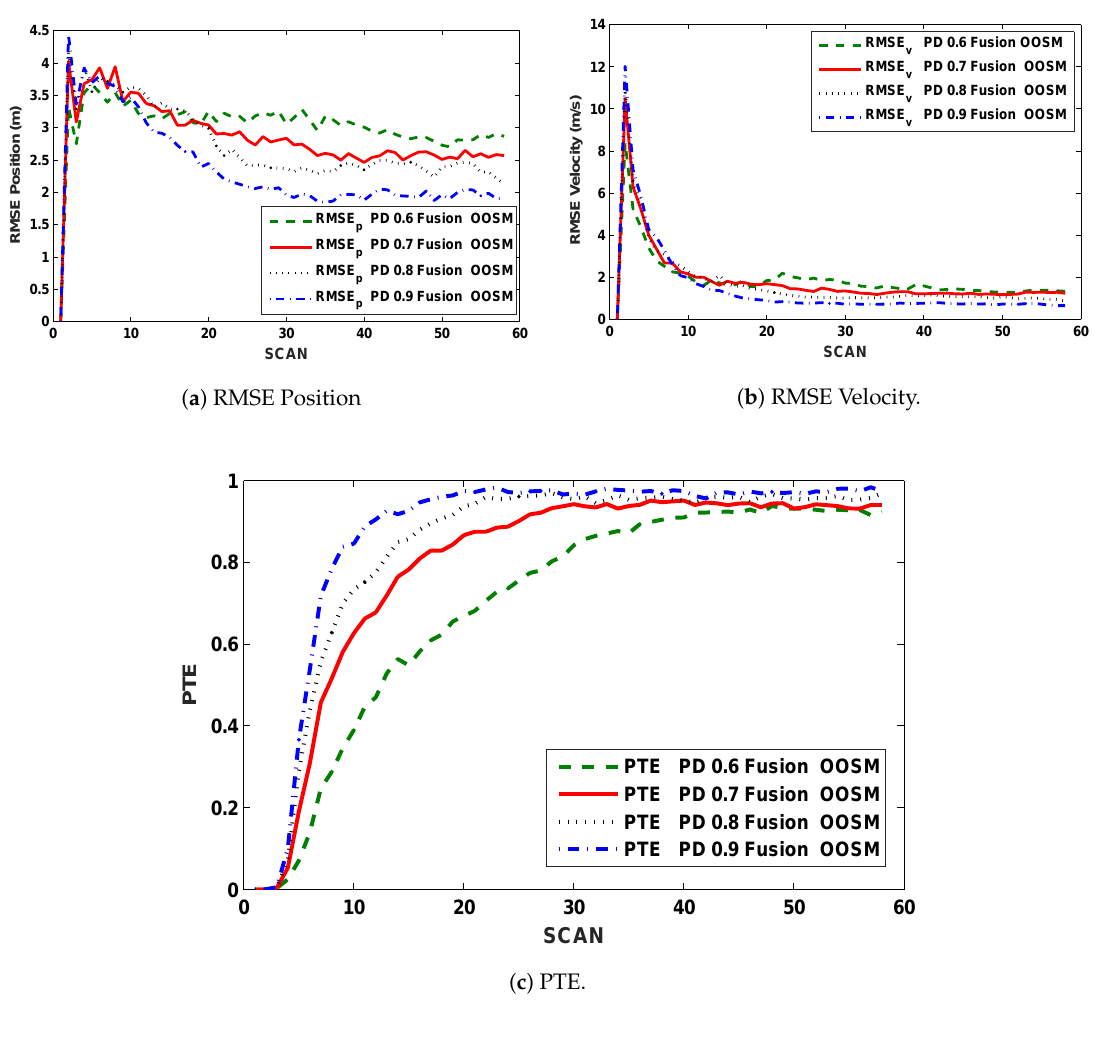
Figure 4. Comparison of RMSEs and PTE for multiple P Ds (Proposed Algorithm).